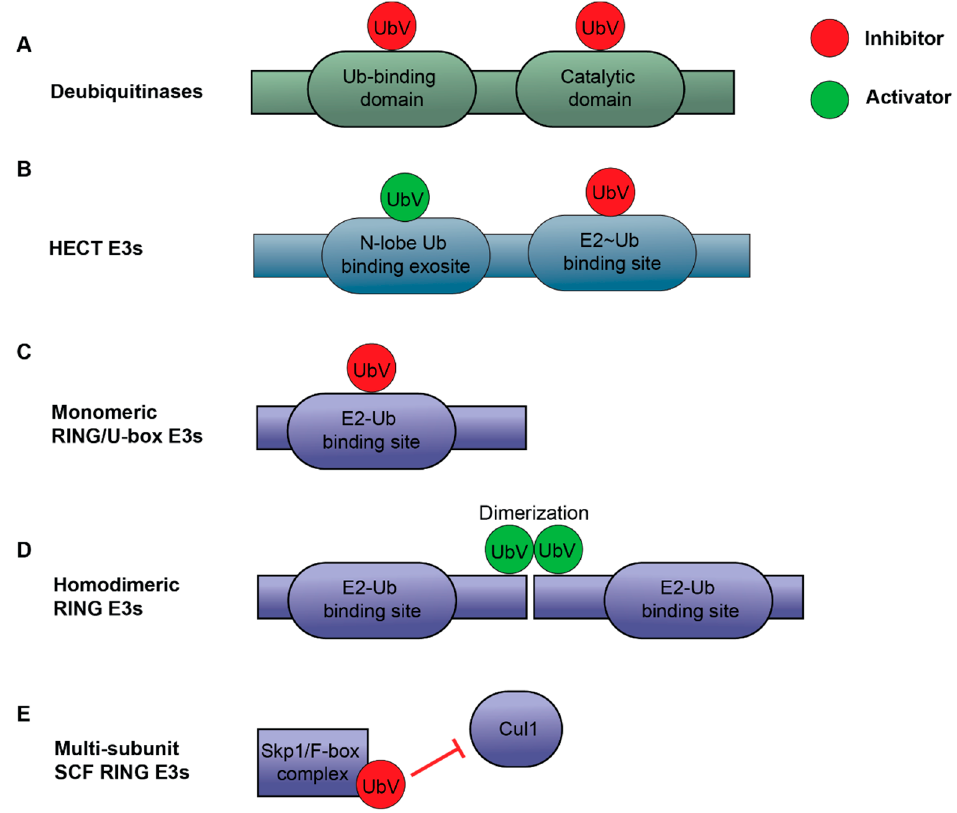
Figure 7. Ubiquitin variants (UbVs) as modulators of the ubiquitin proteasome system (UPS) com- ponents. ( A ) UbVs can bind to either the catalytic domain or the ubiquitin (Ub) binding domain, thereby inhibiting the parent protein’s function, as seen in the USP subfamily of DUBs. ( B ) UbVs are either activating or inhibitory for HECT-family E3 ligases depending on the binding site on the HECT domain. ( C – E ) UbVs can act as an inhibitor or activator for RING/U-box E3 ligases. ( C ) As an inhibitor for monomeric RING/U-box E3 ligases, UbV prevents E2~Ub binding. ( D ) For homodi- meric RING E3 ligases (e.g., XIAP), UbV can dimerize to engage binding with homodimeric RING domain to stimulate E3 activity (middle). ( E ) For multi-subunit SCF-family RING E3 ligases, UbV disrupts the complex formation to inhibit catalytic functions of E3 ligases.